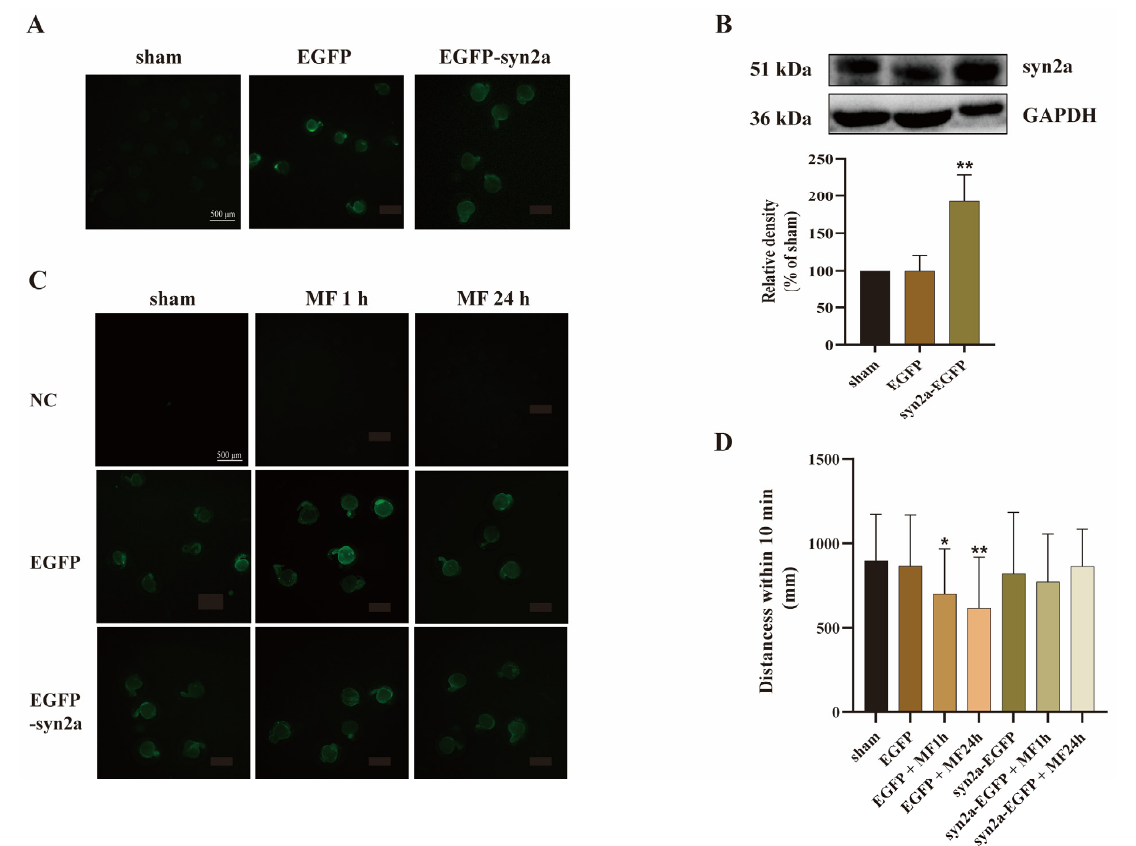
Figure 3. Overexpression of syn2a could restore MF-weakened SM in zebrafish. ( A ) EGFP could be expressed in zebrafish larvae which transfected with pCS2 + plasmid vector or pCS2 + -syn2a-EGFP plasmid. Scale bar represents 500 µ m; ( B ) Syn2a was overexpressed in zebrafish larvae transfected with pCS2 + -syn2a-EGFP plasmid; ( C ) All of zebrafish embryos, which were transfected plasmid vector or syn2a overexpression plasmid and used in MF exposure experiment could express EGFP. Scale bar represents 500 µ m; ( D ) Syn2a overexpression plasmid could restore MF-inhibited SM distances of zebrafish at 120 hpf. * p < 0.05, ** p < 0.01, compared with